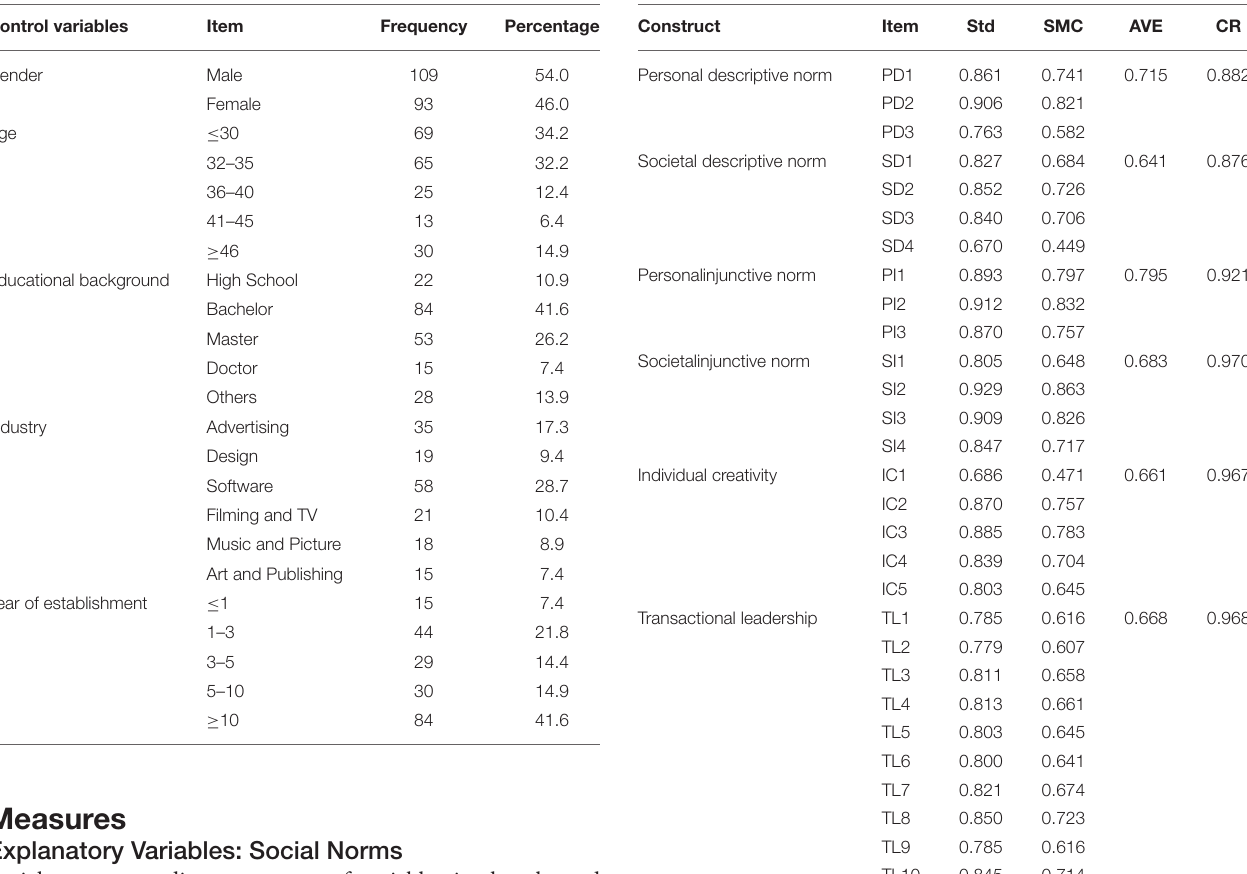
TABLE 1 | Characteristics of the research samples ( N = 202). TABLE 2 | Validity and reliability of construct measures ( N =